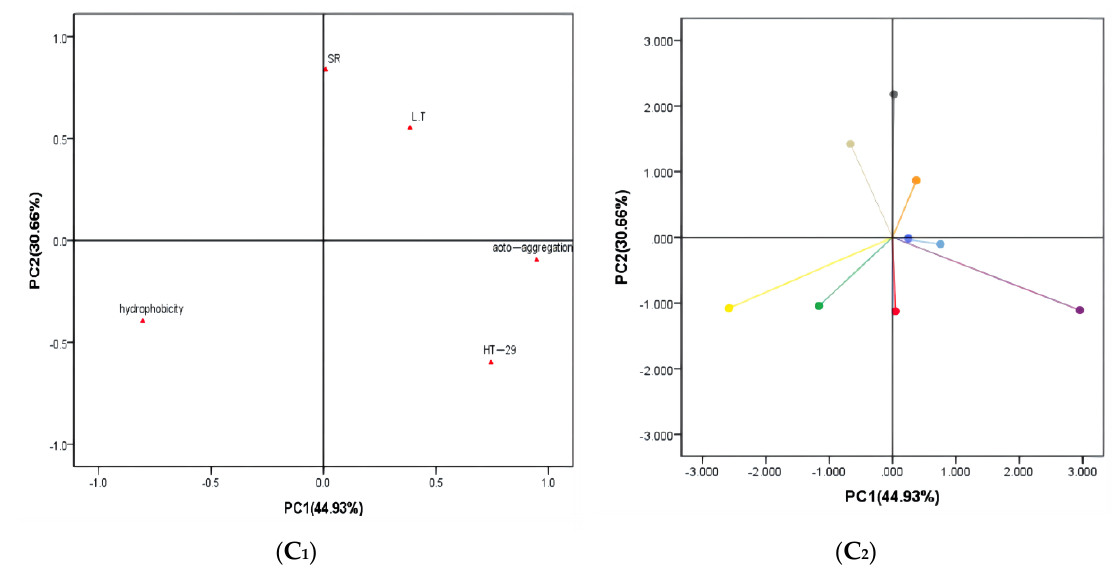
Figure 3. Comprehensive evaluation of LAB by principal component analysis. A: Hypoglycemic ability; B: Antioxidant activity; C: Probiotic property. ( A 1 ), ( B 1 ) and ( C 1 ) represent factor loading; ( A 2 ), ( B 2 ) and ( C 2 ) represent factor scores of L.plantarum ( ● ), L.rhamnosus ( ● ), L.acidophilus ( ● ), L.delbrueckii ( ● ), L.paracasei ( ● ), L.casei ( ● ), S.thermophilus ( ● ), L.mesenteroides ( ● ), L.lactis ( ● ).